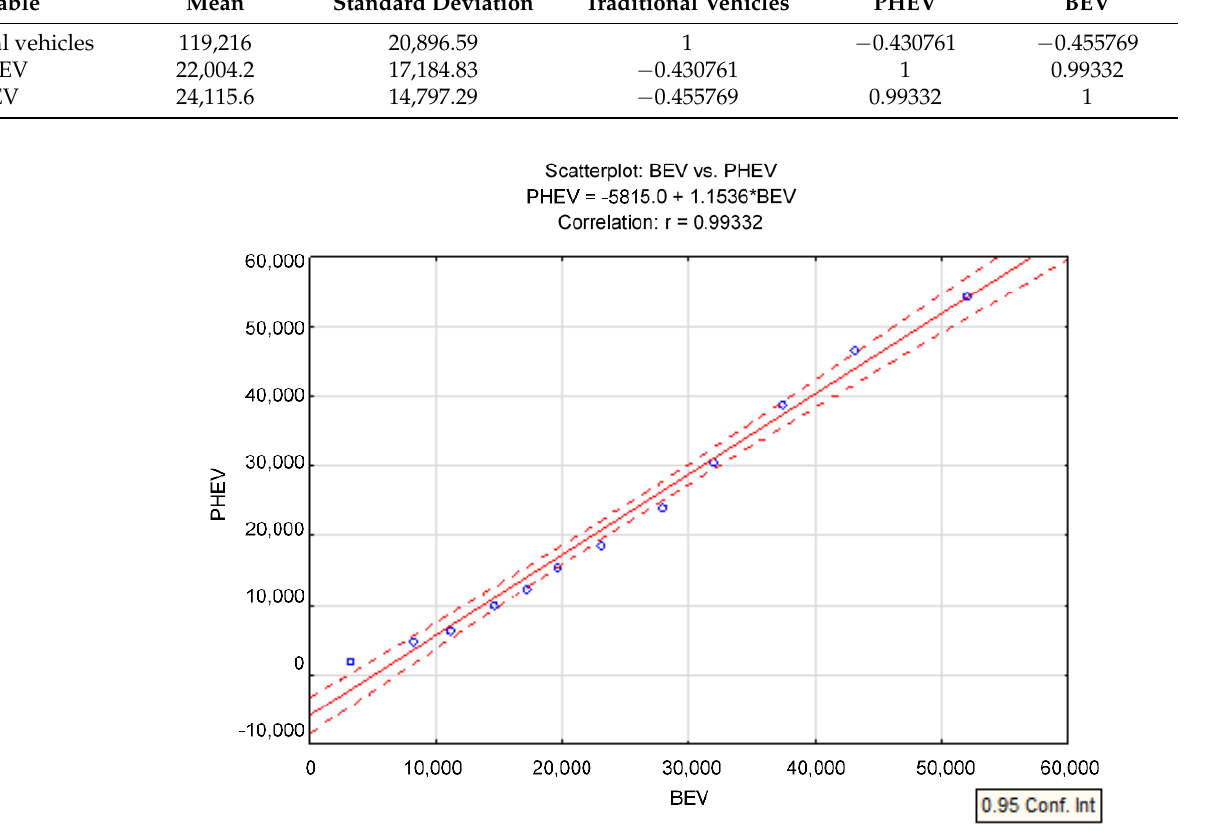
Table 4. Correlation relationship of AC and DC variables for p < 0.05000, N = 33.